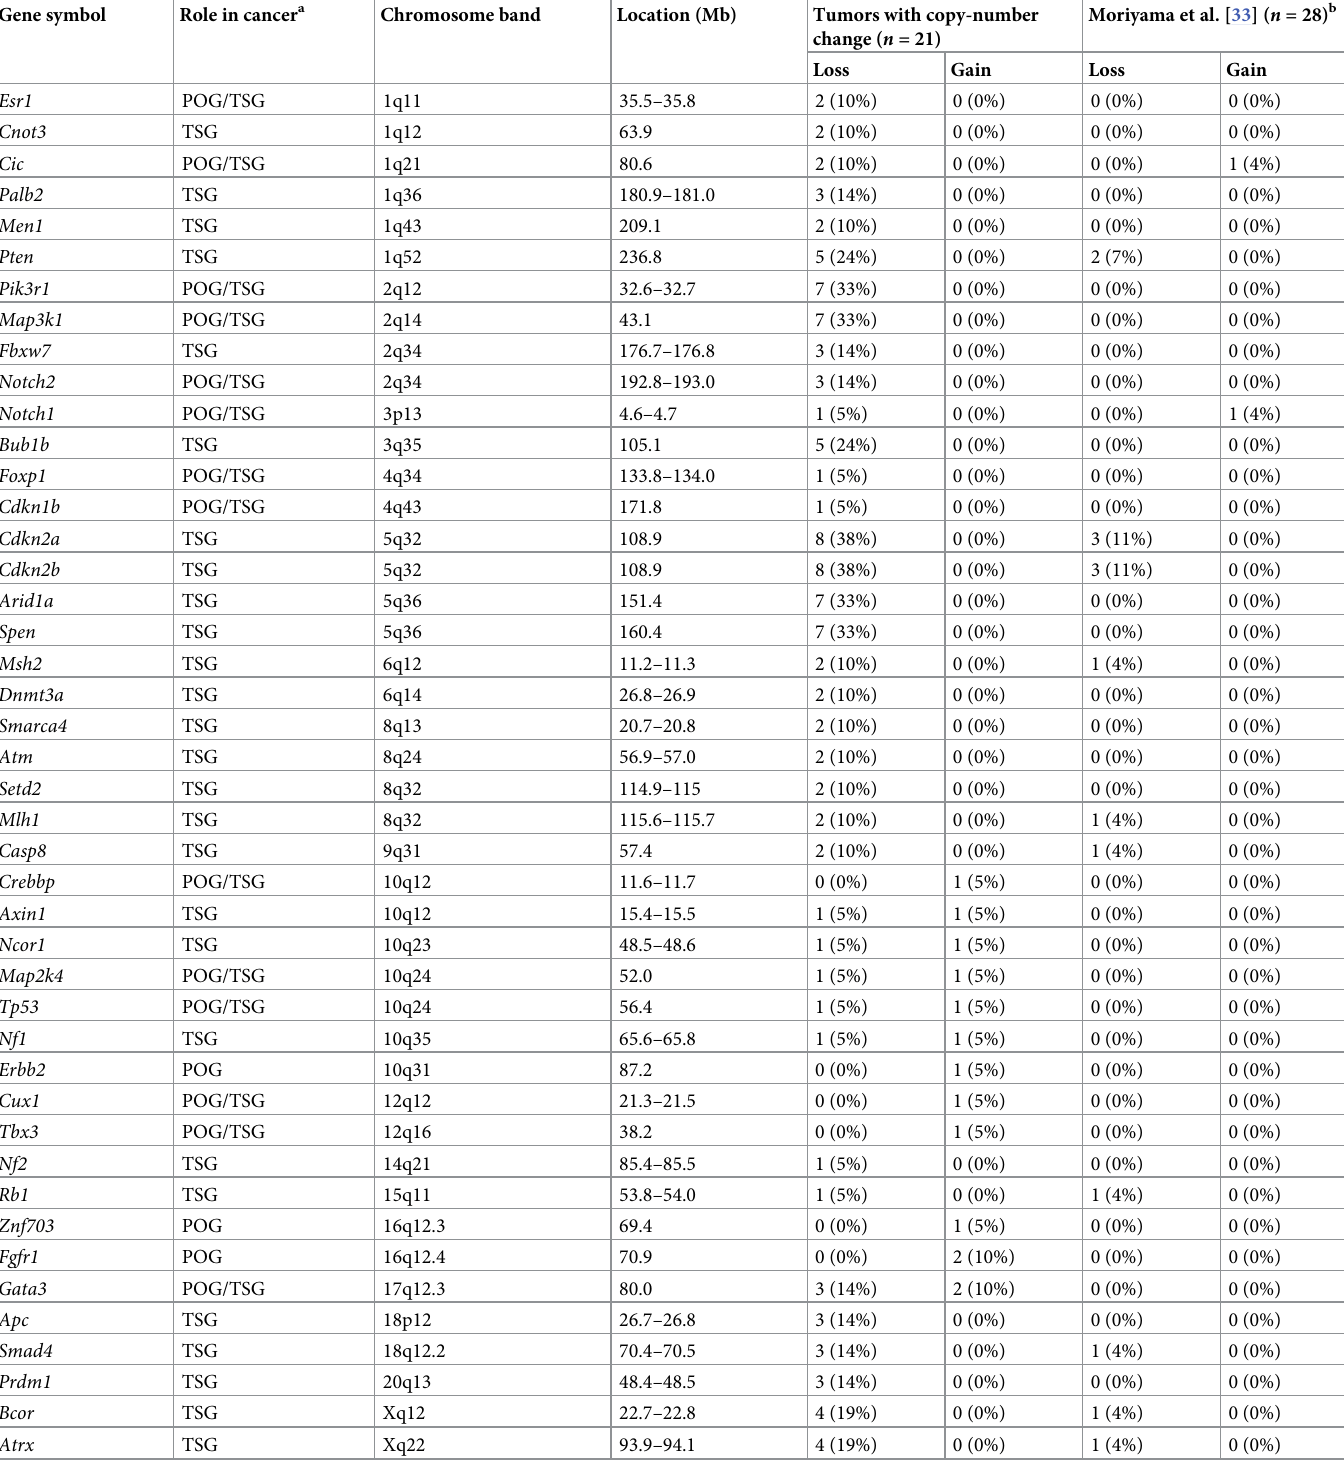
Table 6. Human breast cancer–related genes in chromosomal regions exhibiting meaningful copy-number changes in (SD × COP)F 1 mammary carcinoma. Gene